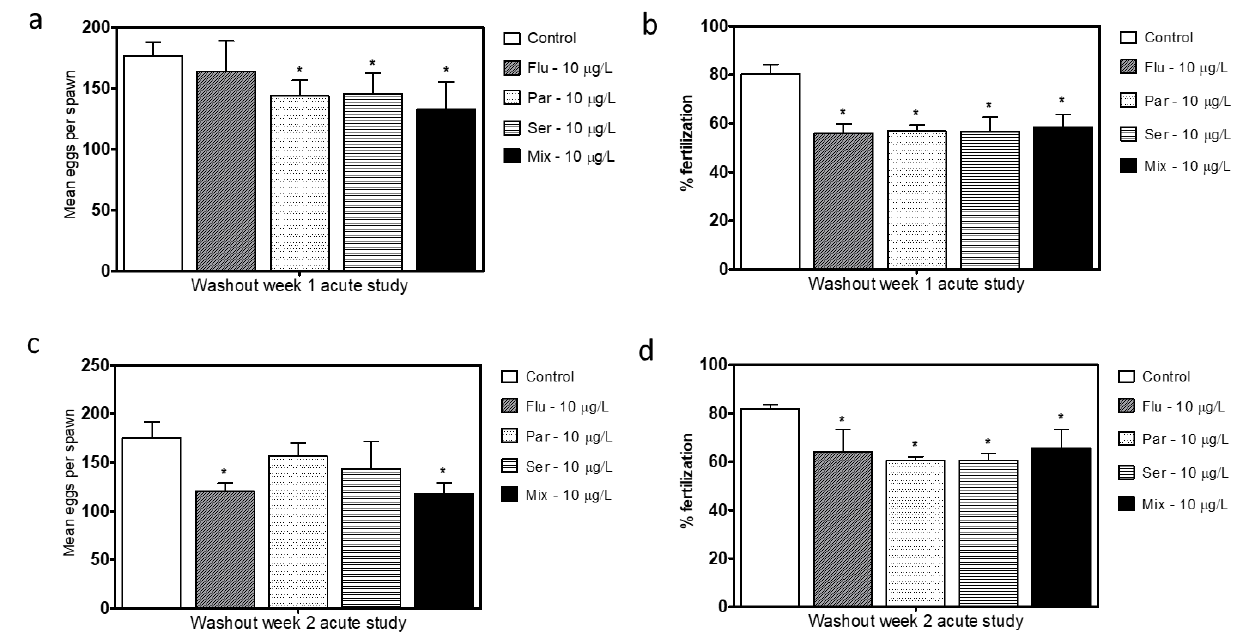
Figure 7. Mean number of eggs generated per single pair cross (all eggs regardless of viability) during week 1 ( a ) and week 2 ( c ) following the short-term exposure 2 week washout period for all treatment groups (Flu- Fluoxetine, Par—Paroxetine, Ser—Sertraline, Mix—mixture of all three compounds). Percent fertilization of clutches during week 1 ( b ) and week 2 ( d ) following the 2 week washout. Statistical significance with respect to the control fish group was determined using a one-way ANOVA followed by a Dunnett’s multiple comparisons test (* p < 0.05).